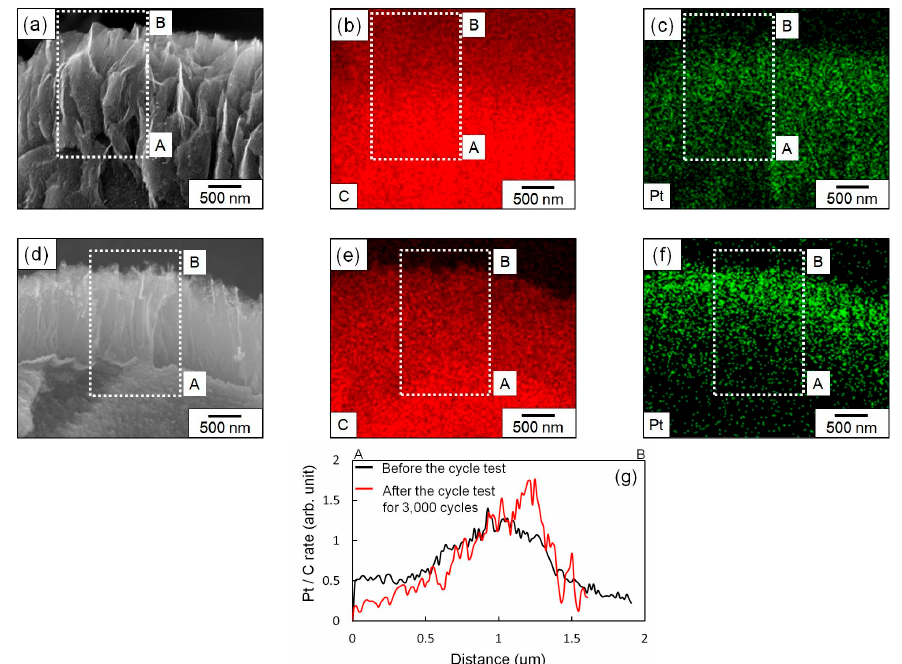
Figure 2. ( a ) SEM image of cross-sectional view of Pt-decorated CNWs grown on carbon fiber.